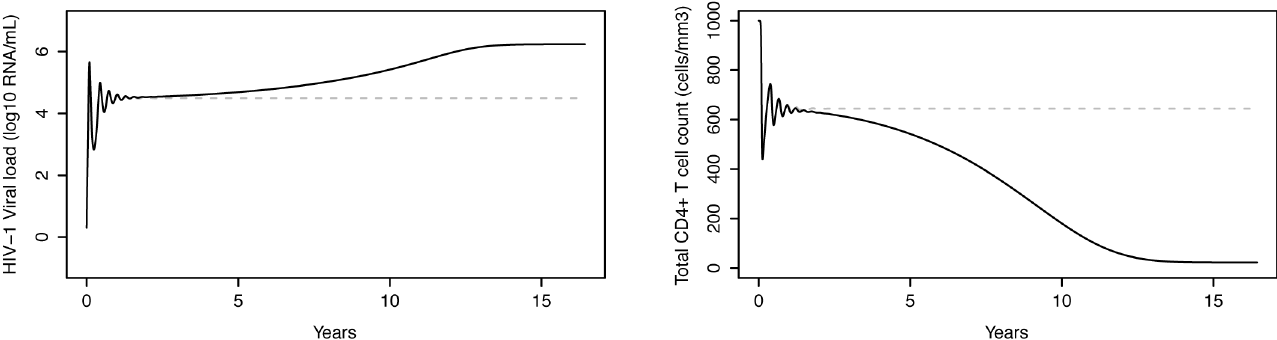
Fig 3. Evolution of plasma HIV-1 RNA levels and CD4+ T cell counts in an untreated subject. Left: Plasma HIV-1 RNA levels as a function of time, simulated by the HIV-D model accounting for disease progression. Right: corresponding CD4 + T cell counts. The model simulates the 3 typical stages of HIV- 1 infection: acute infection, clinical latency and AIDS phase. Dashed grey lines represent the HIV-D model without disease progression, the stable-state solution of which is exploited to introduce between-patient variability in plasma cell